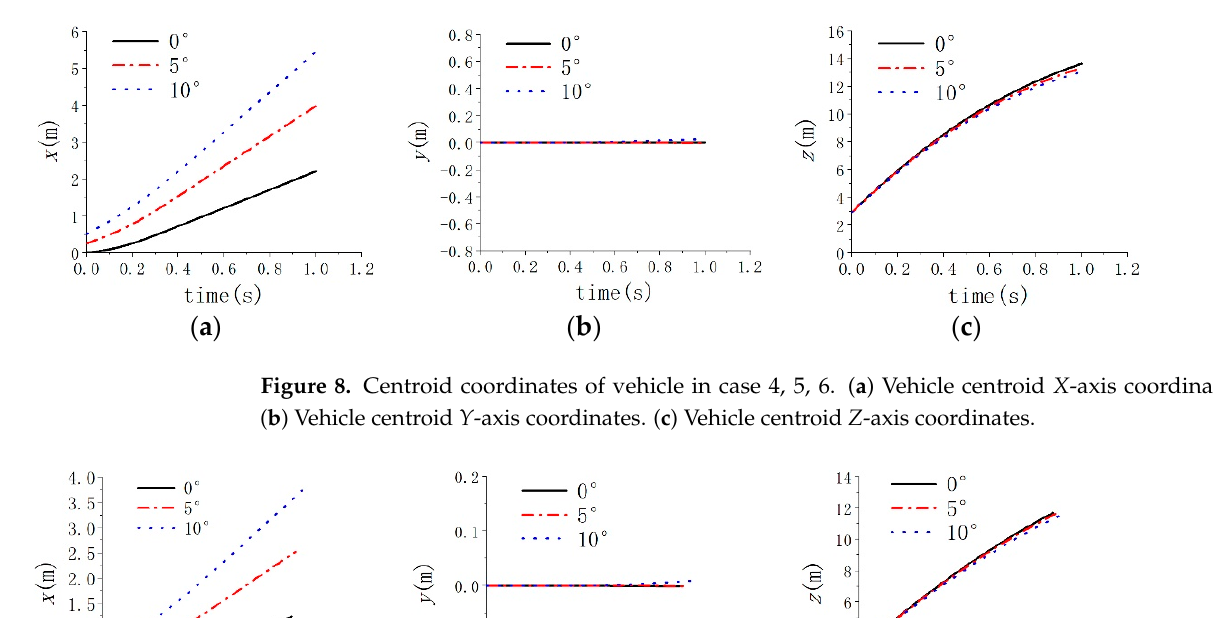
Figure 7. Centroid coordinates of vehicle in case 1, 2, 3. ( a ) Vehicle centroid X -axis coordinates. ( b ) Vehicle centroid Y -axis coordinates. ( c ) Vehicle centroid Z -axis coordinates.